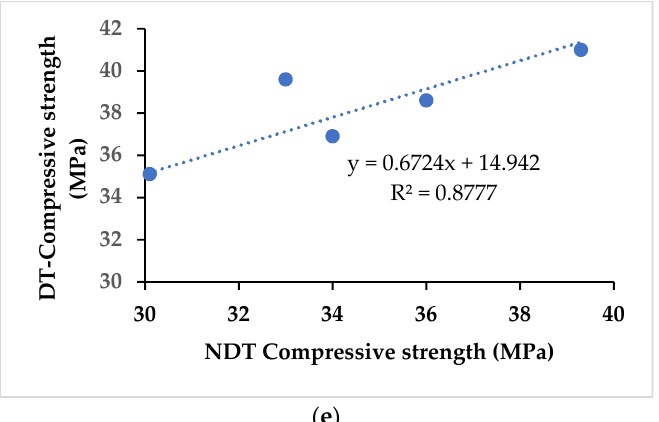
Figure 13. Prediction of compressive strength via rebound hammer values at each CS40% group. ( a ) 0.0%PPF; ( b ) 0.2%PPF; ( c ) 0.4%PPF; ( d ) 0.6%PPF; ( e ) 0.8%PPF.